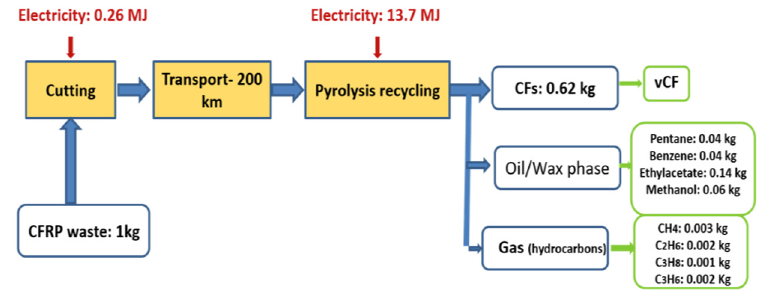
Figure 19. Flow diagram of pyrolysis recycling.